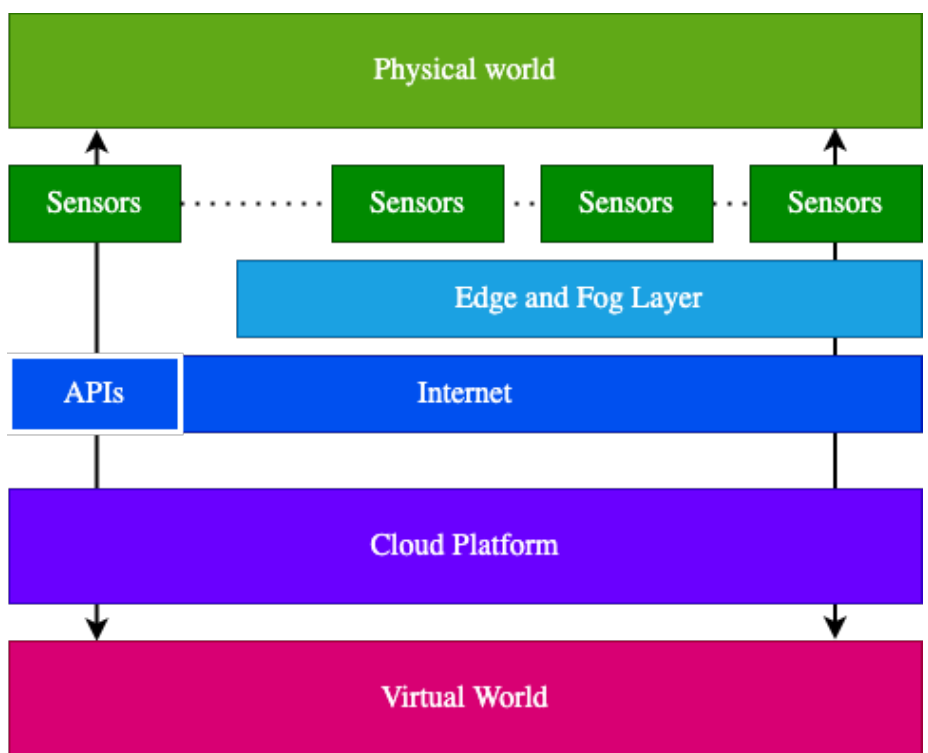
Figure 1. General Internet of Things (IoT)